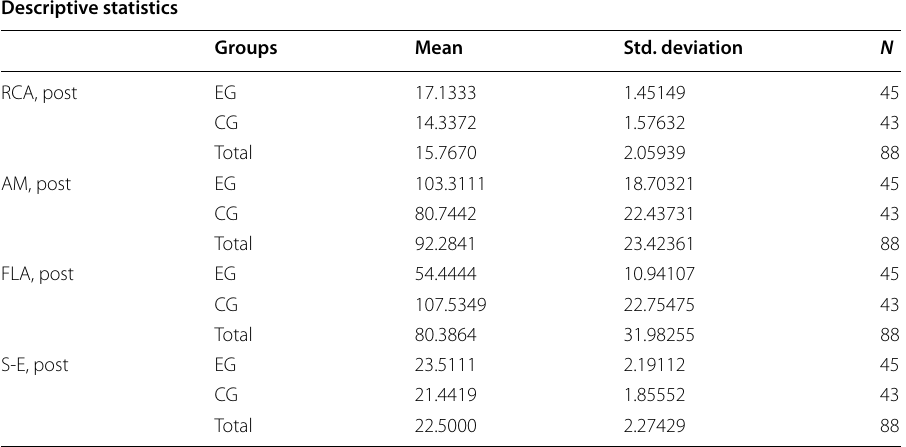
Table 3 Results of descriptive statistics for RCA posttest, AM posttest, FLA posttest, and SS-E